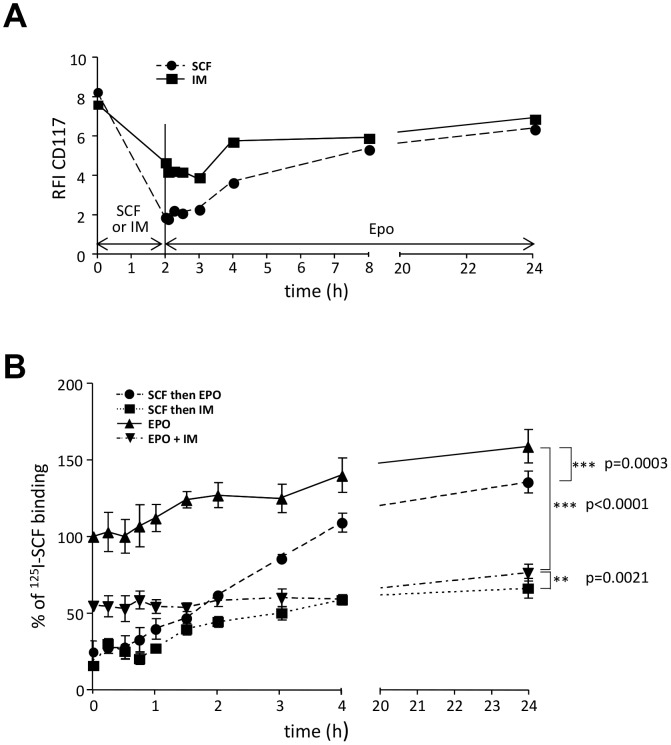
Imatinib prevents c-Kit receptor re-expression after SCF-induced down-regulation.
A. Down-regulation of c-Kit by imatinib is reversible. UT-7/Epo cells were incubated with 50 ng/ml SCF (dotted line) or with 2 µM imatinib (filled line) for 2 h. After washing in PBS, cells were cultured with 1 UI/ml Epo for 24 h. CD117 expression was measured at the indicated times by flow cytometry and results were expressed as RFI. B. Imatinib prevents the re-expression of functional c-Kit after SCF binding. UT-7/Epo cells were pre-incubated with 50 ng/ml SCF. After washing in PBS, SCF-treated cells were re-seeded with 1 UI/ml Epo in the presence or absence of 2 µM IM for 24 h. Cells cultured with 1 UI/ml Epo in the presence or absence of IM were used as controls. At indicated times, cells were labeled with 200 ng/ml [125I]SCF for 90 min at 4°C and the radioactivity was determined. Results were expressed as percentages of [125I]SCF binding to Epo alone at time 0 and are the mean (± SD) of three independent experiments.